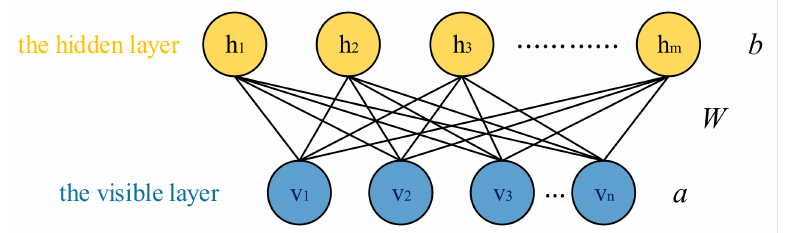
Figure 1. Restricted Boltzmann machine